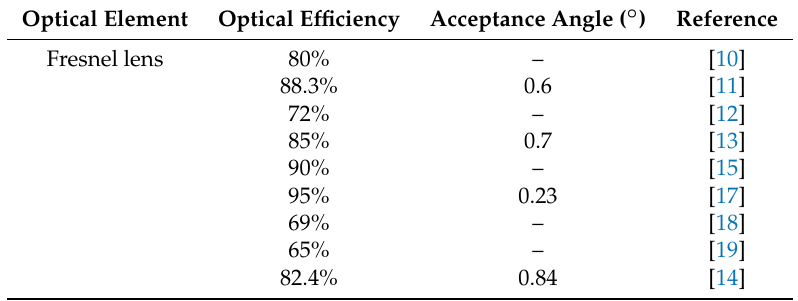
Table 3. Optical efficiency and acceptance angle for each optical